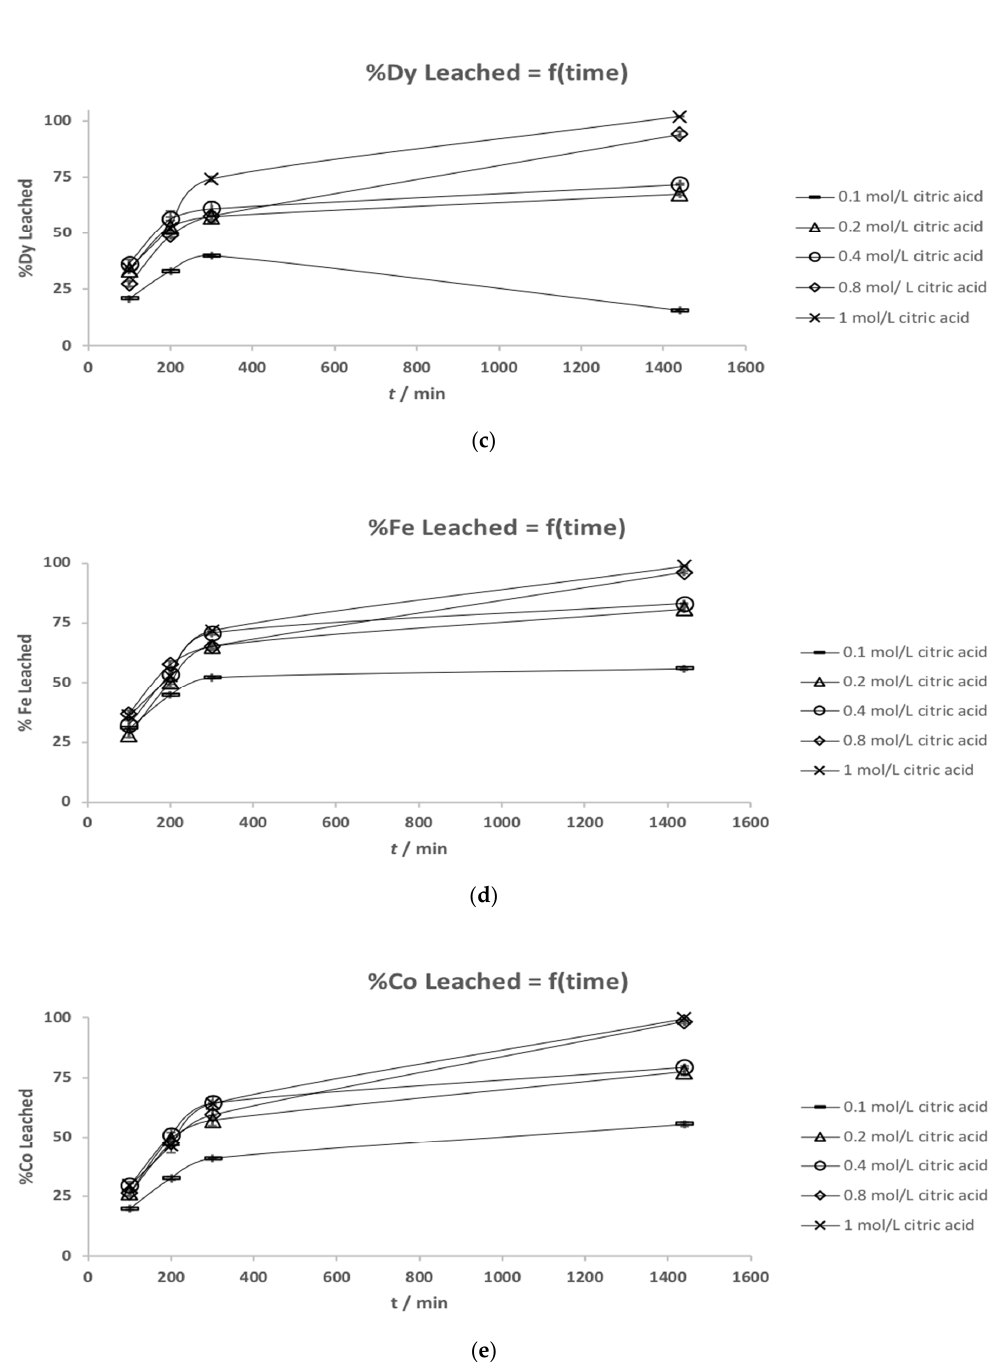
Figure 4. Effect of the concentration of citric acid (0.1, 0.2, 0.4, 0.8 and 1 mol/L) and leaching time (100 min, 200 min, 300 min and 24 h) on the leaching efficiency of ( a ) Nd, ( b ) Pr, ( c ) Dy, ( d ) Fe, and ( e ) Co. The temperature was kept at 25 ± 1 °C by, magnetic stirring at 400 rpm, and S:L ratio at 1/50 g/mL. As in the case of acetic acid, the effect of variation in the concentration of citric acid was observed to influence the leaching efficiency of the components of the roasted neodymium powder (Figure 4). Increasing the concentration of citric acid from 0.1 mol/L to 1 mol/L increased the leaching efficiency for the REEs from <20% to >95%, reaching the highest leaching efficiency after 24 h. The increase in the leaching efficiency of REEs was accompanied by the co-leaching of Fe, B, and Co into the solution. The pH value of the leaching acid measured increased from 1.23 to 2.5 from 1 mol/L to 0.1 mol/L, while the values after 24 h leaching were 2.3, 2.6, 3.4, 4.5, and 5.3 for 1 mol/L, 0.8 mol/L, 0.6